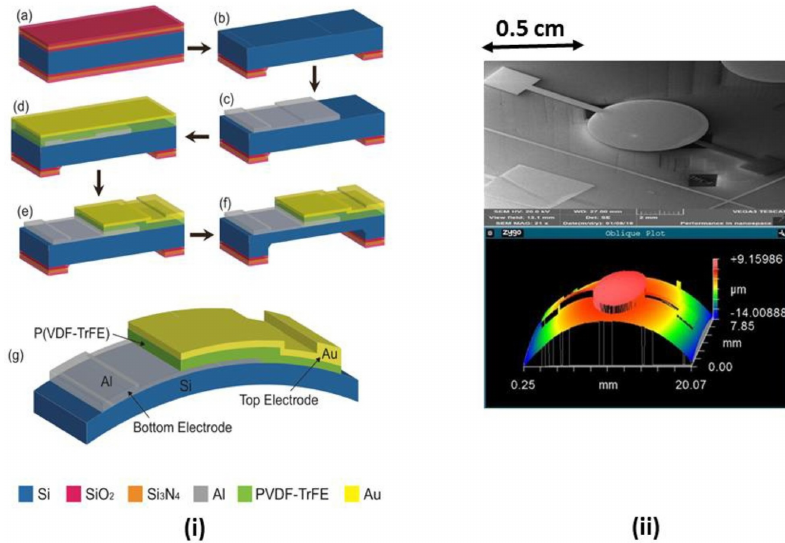
Figure 15. ( i ) Steps to fabricate ultra-thin silicon based PVDF-TrFE capacitors: ( a ) Hard mask growth ( b )Backside patterning to open etching window ( c ) Bottom metal deposition and patterning ( d ) PVDF-TrFE spin coating, annealing and top metal deposition ( e ) Patterning top metal and dry etching of polymer ( f ) Wet etching of bulk silicon ( g ) Final device on thin silicon ( ii ) ( top ) Scanning Electron Microscopy image of the piezo-capacitor sensor ( bottom ) optical profilometer image showing warp image of thin chip with the piezo-capacitor. Reprinted with permission from [110] c (cid:13) 2016